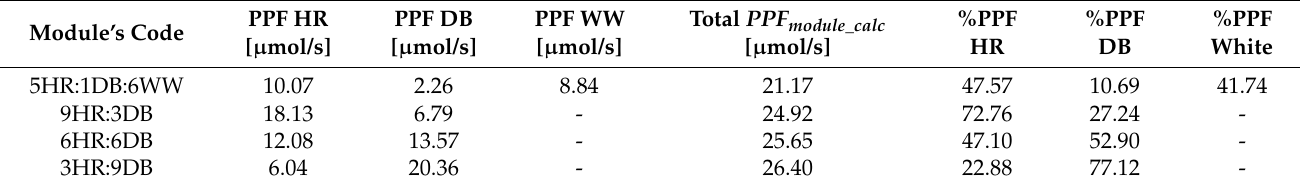
Table 3. Calculation of the PPF composition for each considered module.